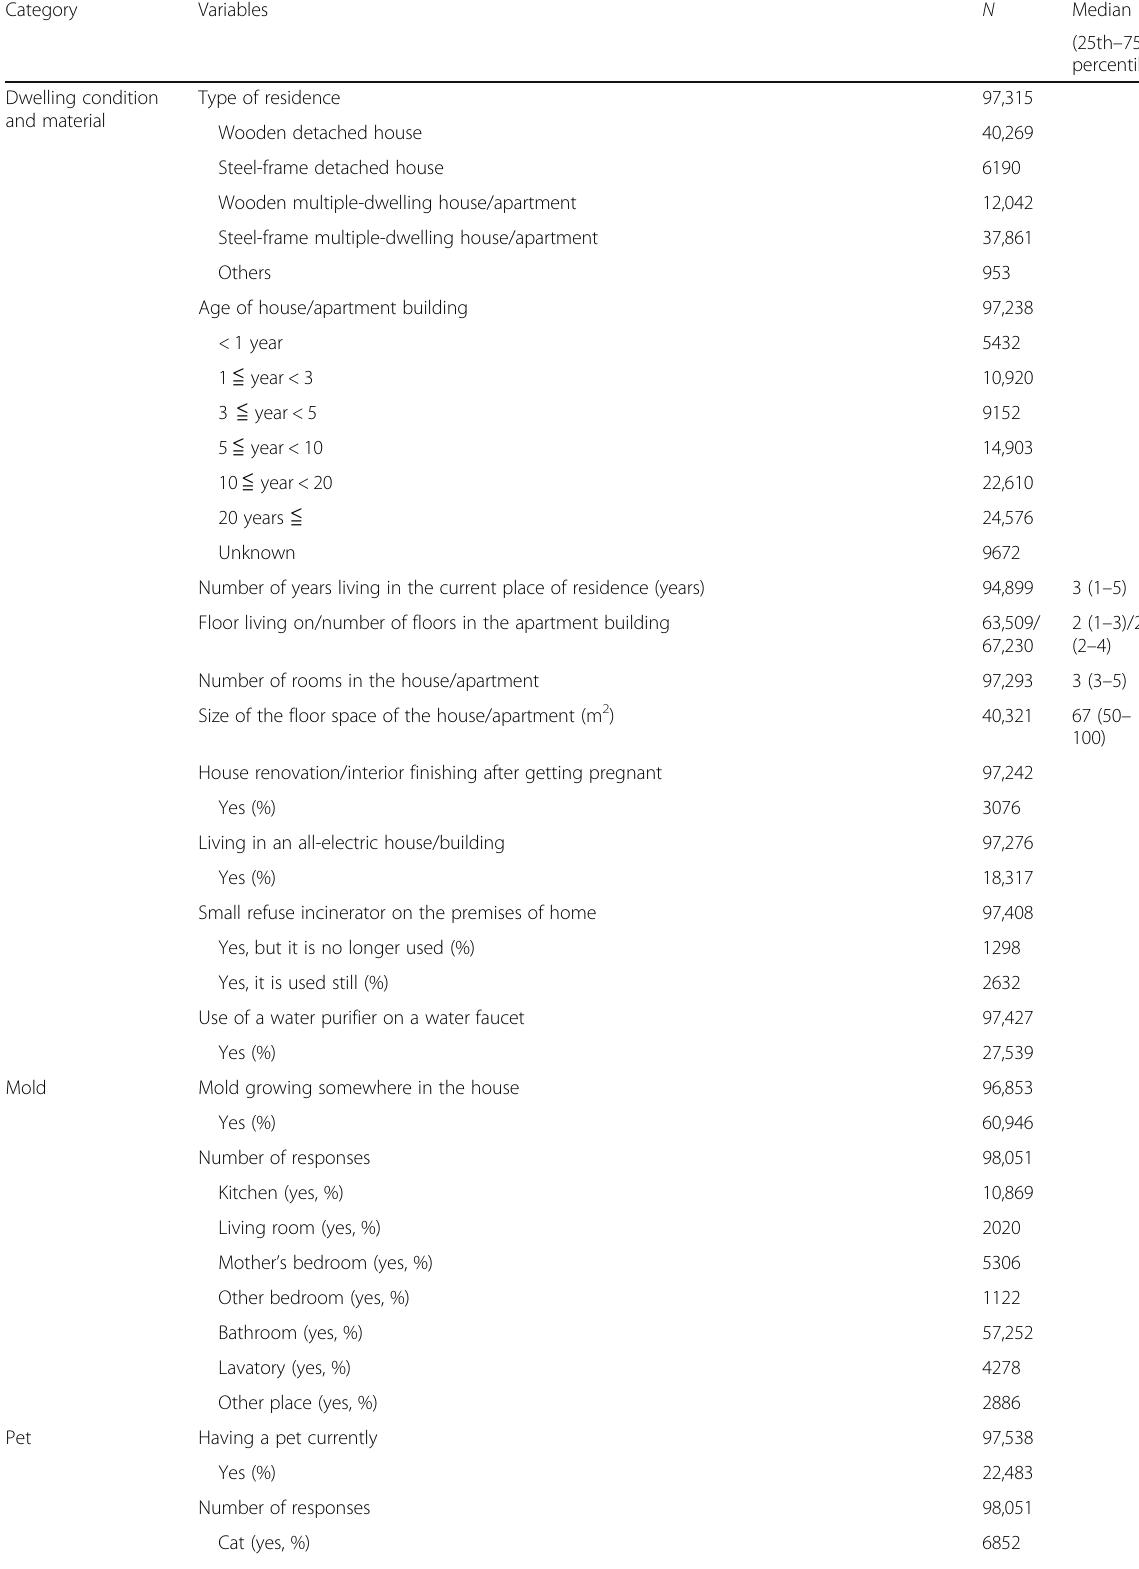
Table 5 Household environment characteristics during pregnancy (MT2)